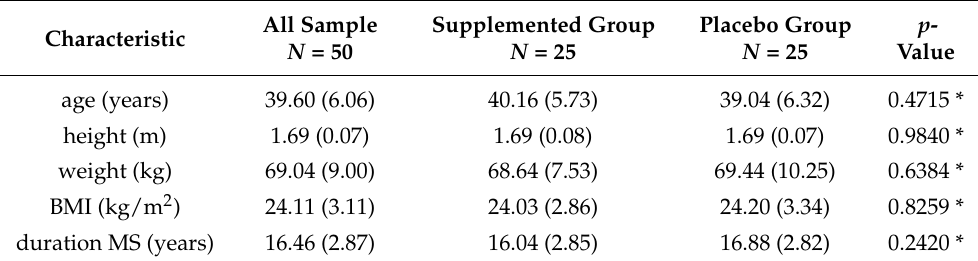
Table 1. Demographic and Anthropometric mean values of entire group of participants and the two single subgroups. Standard deviations indicated within the brackets. The p -values were calculated using the Mann–Whitney U test analysis.